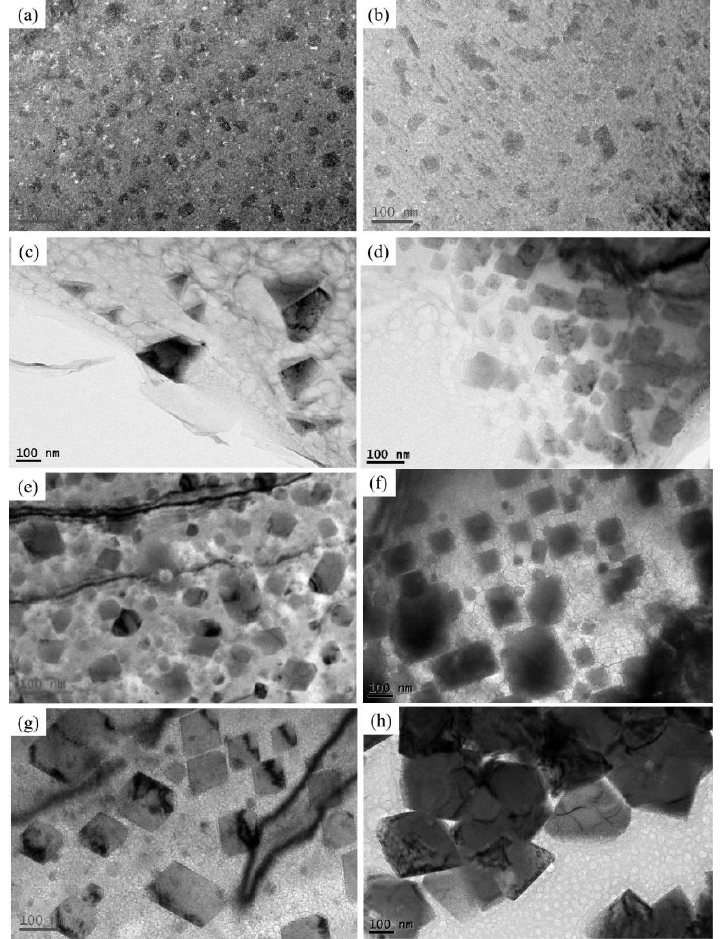
Figure 12. TEM micrograph of β phases in Cu-2.7Be sheets annealed at ( a ) 650 °C/15 min, ( b ) 650 °C/30 min, ( c ) 650 °C/45 min, ( d ) 650 °C/1 h ( e ) 770 °C/15 min, ( f ) 770 °C/30 min, ( g ) 770 °C/45 min and ( h ) 770 °C/1 h respectively.